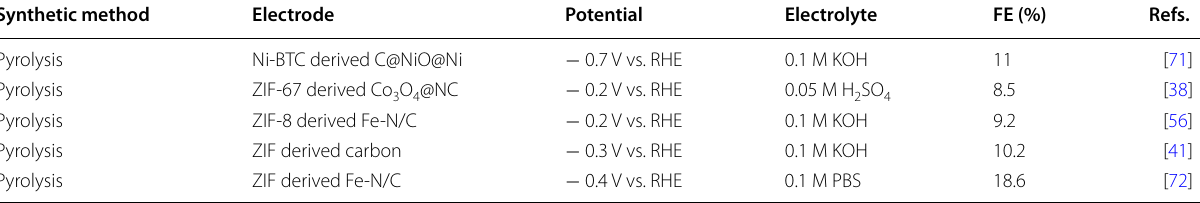
Table 2 Electrocatalytic nitogen to ammonia conversion using MOF‑derived material Synthetic method Electrode